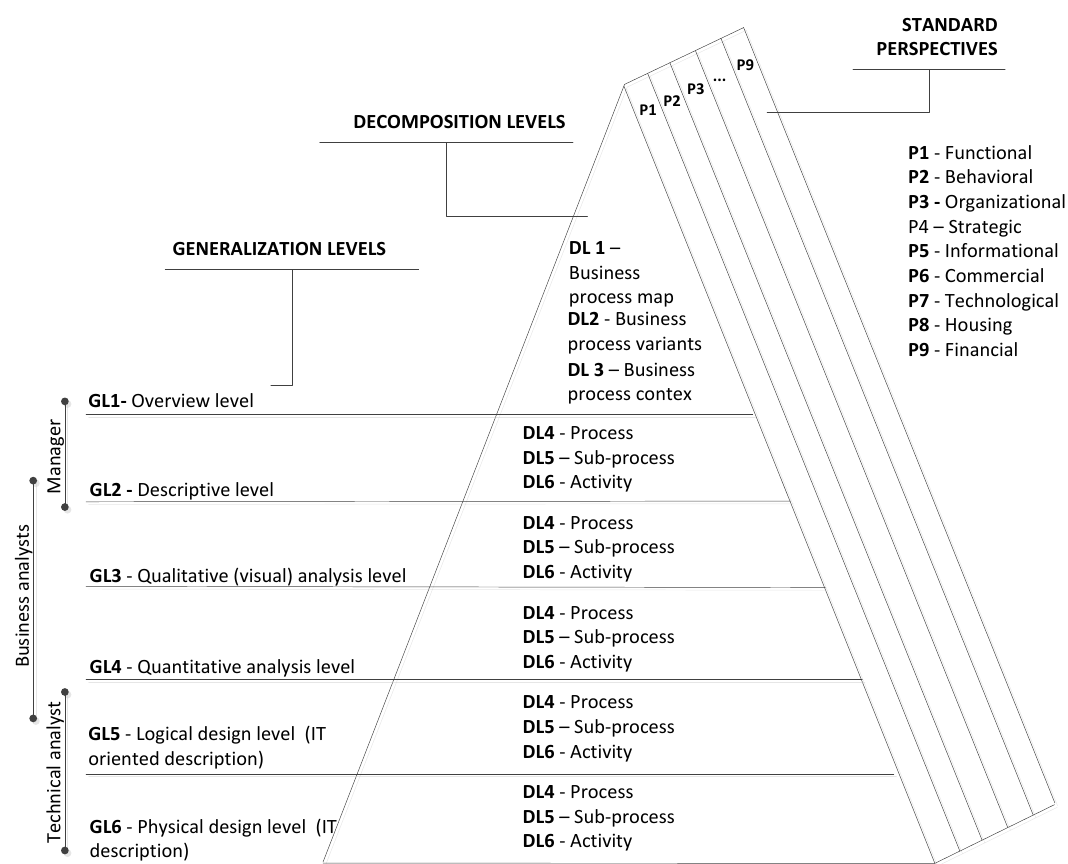
Figure 7. Business Process Modeling